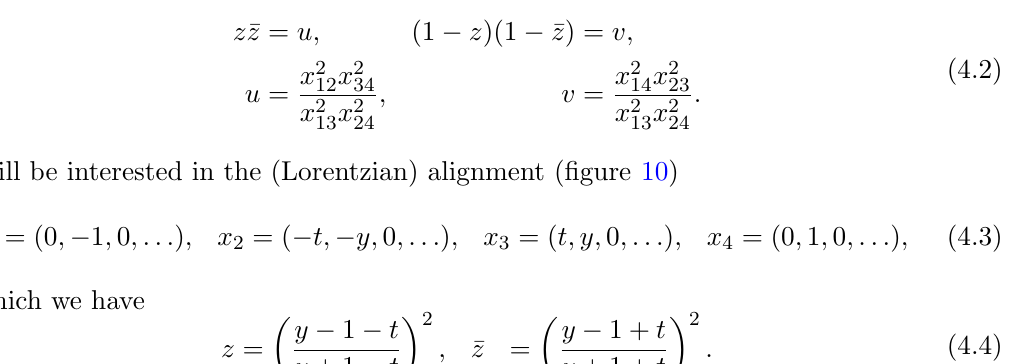
Figure 10 . Operator insertions in the (cid:13)at space correlator. Two operators are in the left and two operators are in the right Rindler wedge. The W operators follow the red lines as we increase Rindler time. When they enter the blue region, the cross ratio (cid:22) z moves to the second sheet. depending only on the conformal cross ratios de(cid:12)ned